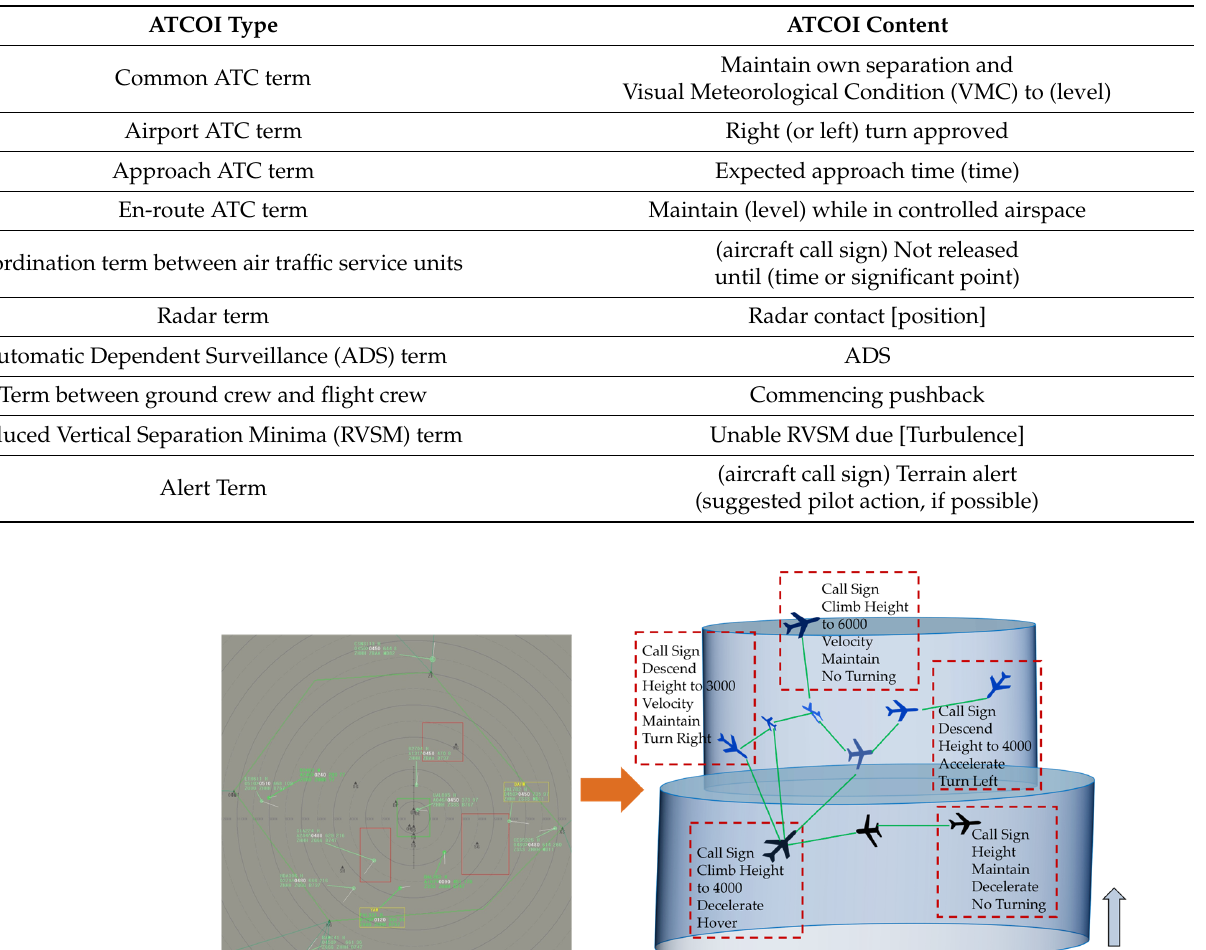
Table 3. Different control types of ATCOI.